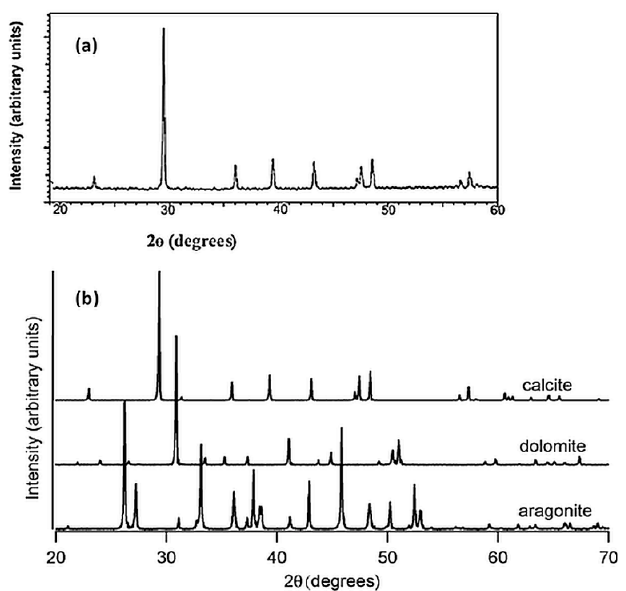
Figure 6. XRD diffractograms of ( a ) CaCO 3 crystals from this study, ( b ) representative XRD of spar calcite, geogenic dolomite, and spar aragonite.